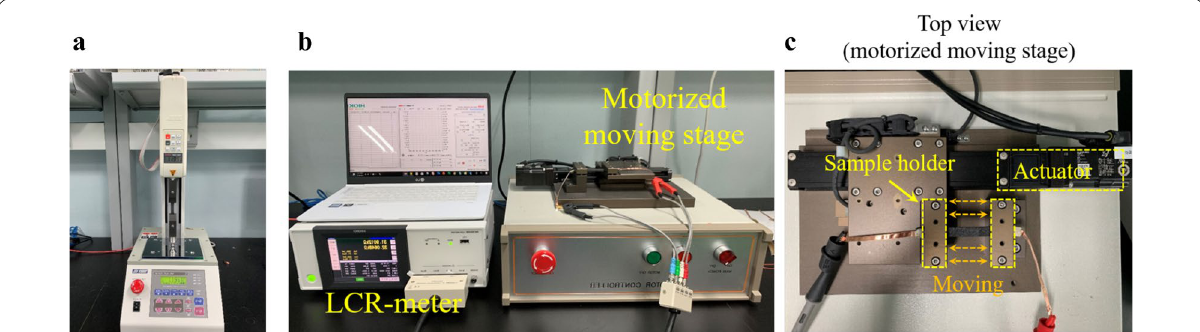
Fig. 2 Experimental setup for the measurement of mechanical properties and changes in resistance for applied strain. a Universal testing machine for measurements of tensile stress–strain. b Setup of measuring the changes in resistance. c Image of fabricated horizontally motorized moving